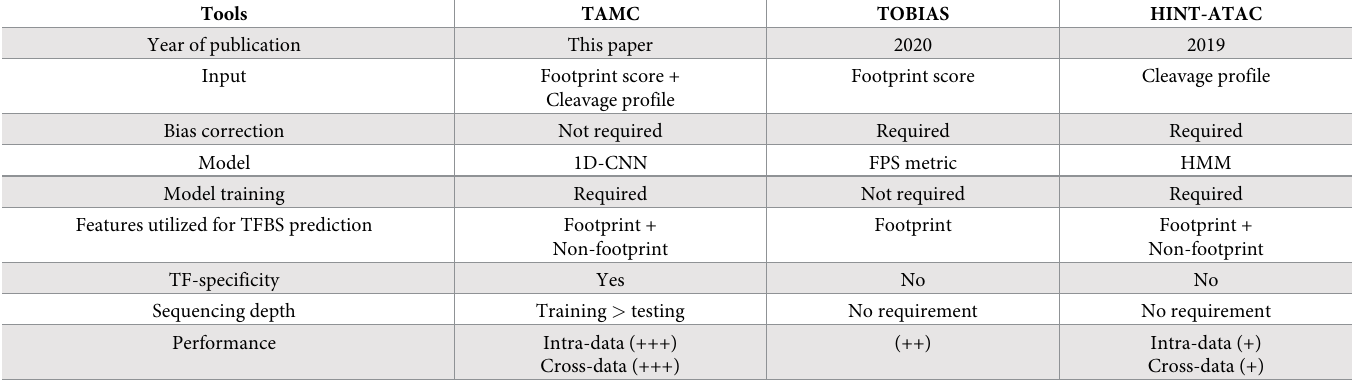
Table 1. Summary of features of TAMC and existing footprinting tools for ATAC-seq data.